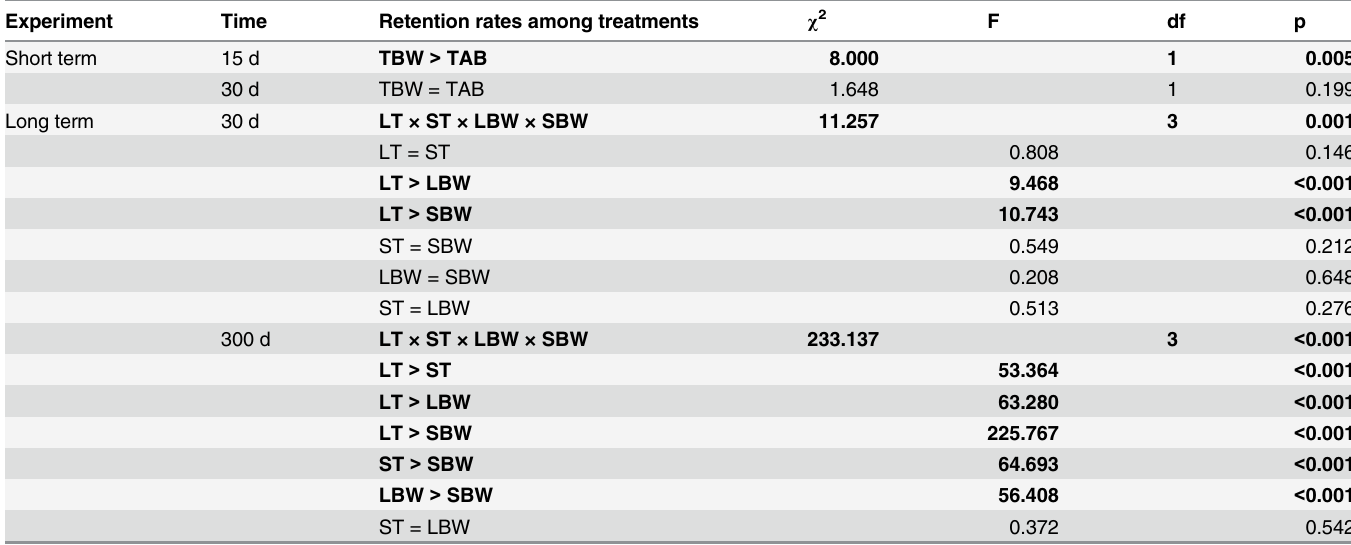
Table 3. Statistical comparison of PIT tag retention rates among treatments in the short-term and long-term experiments.